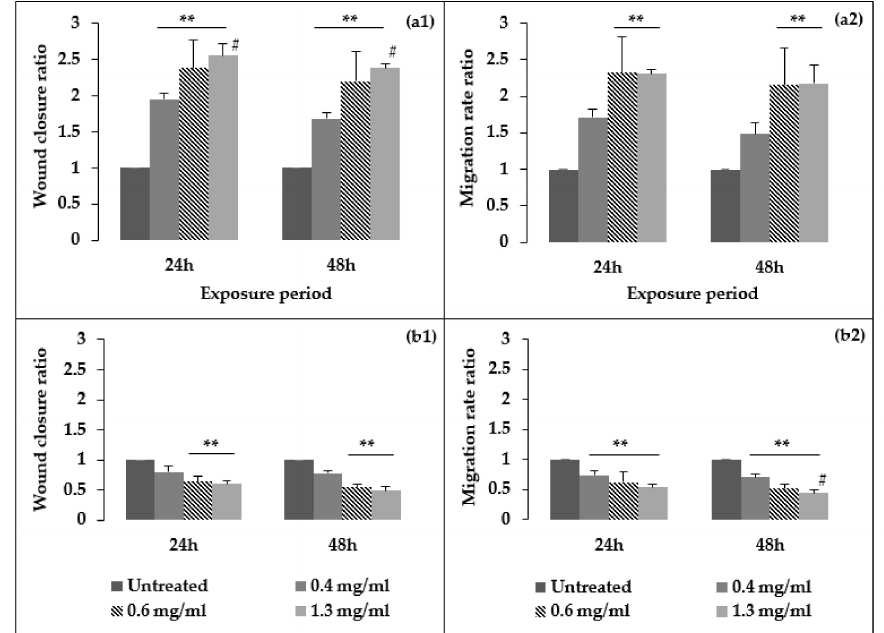
Figure 3. Ratio of percentage wound closure (1) and wound closure rate (2) results after exposure to ( a ) Aloe muth-muth gel and ( b ) Aloe muth-muth whole leaf at 24 h and 48 h treatment periods. Each data point was calculated with respect to the relevant initial wound value at time 0 h and normalized to the untreated control, which was considered as 1. The ** and # indicate statistical significance determined with Tukey’s honest significant di ff erence (HSD) and Kruskal–Wallis tests, respectively, in comparison to the untreated control (significance accepted when p < 0.05).